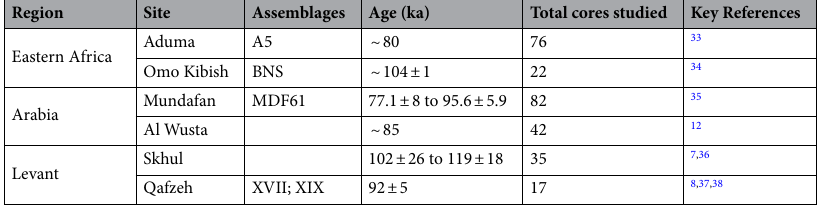
Table 1. Archaeological sites, assemblages, and ages used in this study.